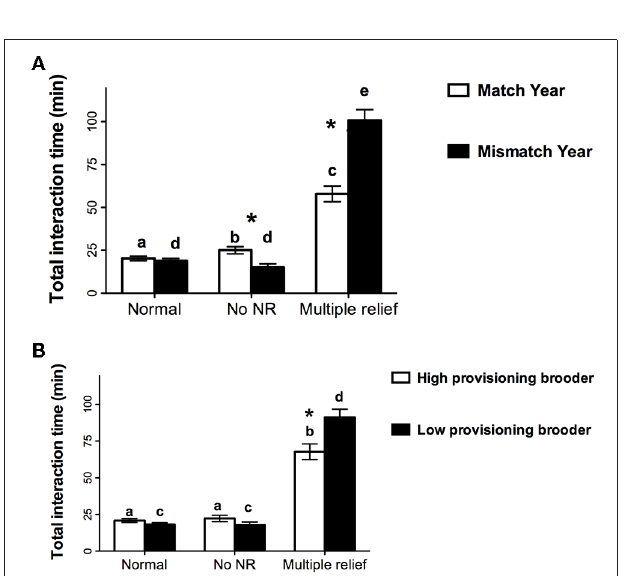
FIGURE 2 | Mean ( ± SE) time for the three types of nest interactions with fish for (A) the match (1999) and mismatch (2000) years and (B) when the brooder was the high or low provisioning member of the pair. Different letters for bars of the same color indicate significant differences among nest relief types whereas * indicates a significant difference for the same nest relief type between years (A) or between high and low provisioners (B) .